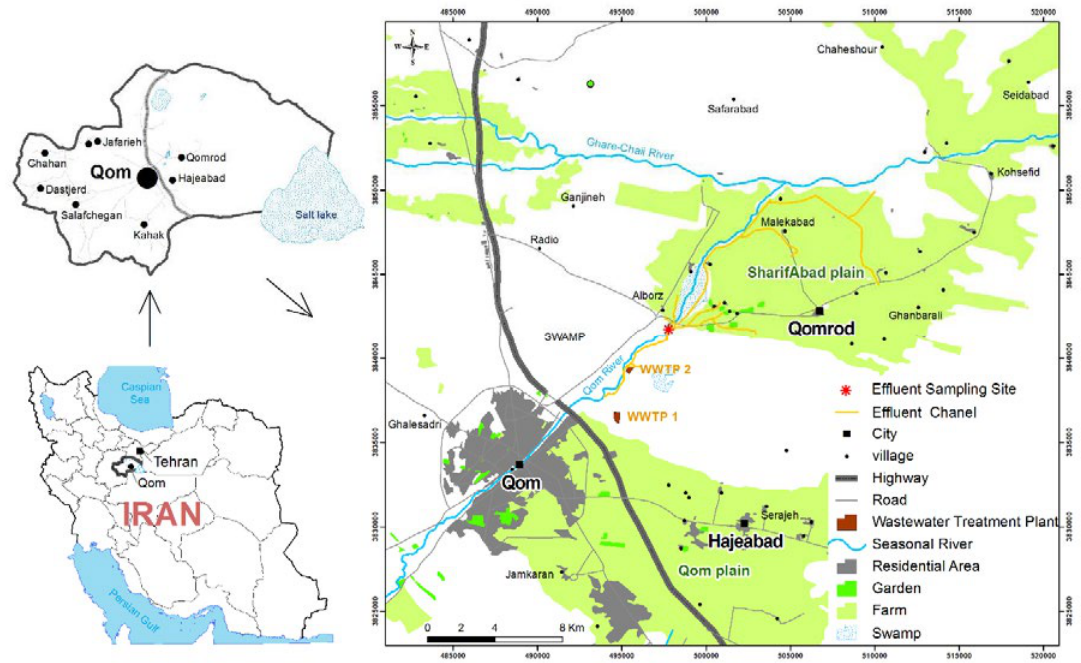
Fig. 1: The study area illustrating the sampling and destination of wastewater